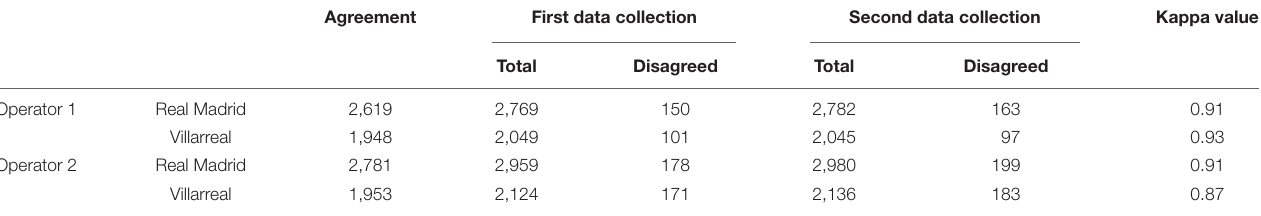
TABLE 4 | Agreement of team events coded by intra-operators.